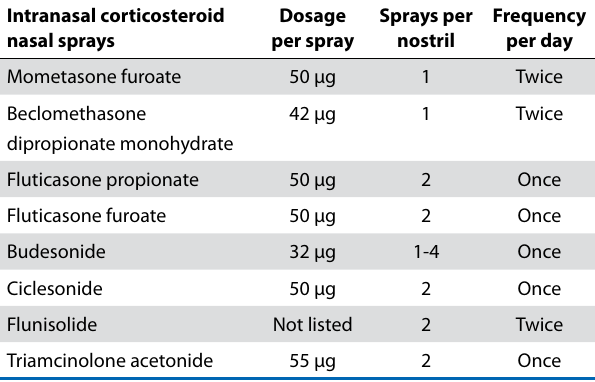
Table III: A list of intranasal corticosteroid nasal sprays 1